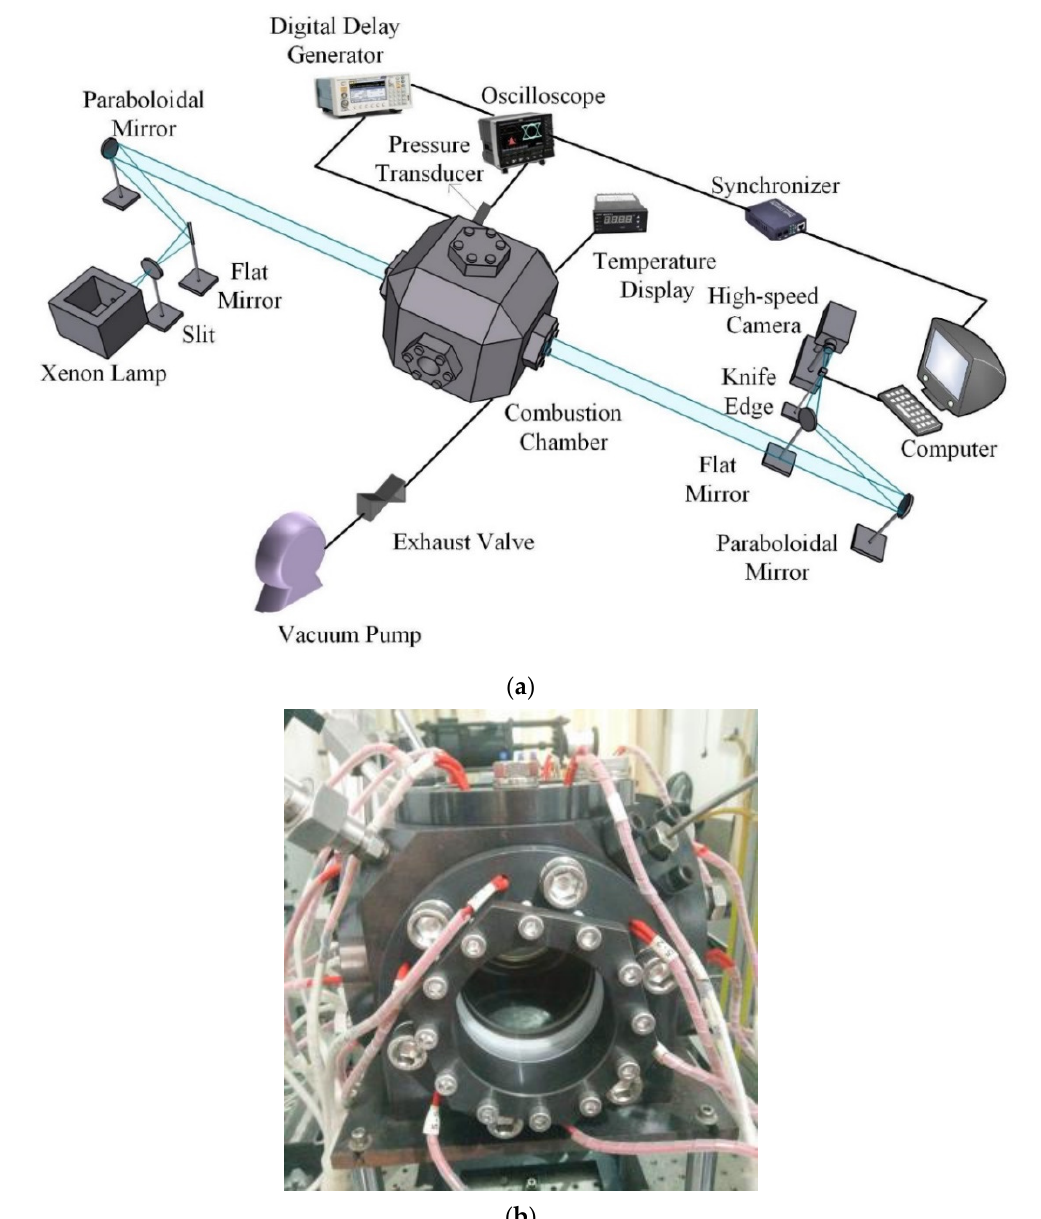
Figure 1. The experimental system ( a ) and the experimental device ( b